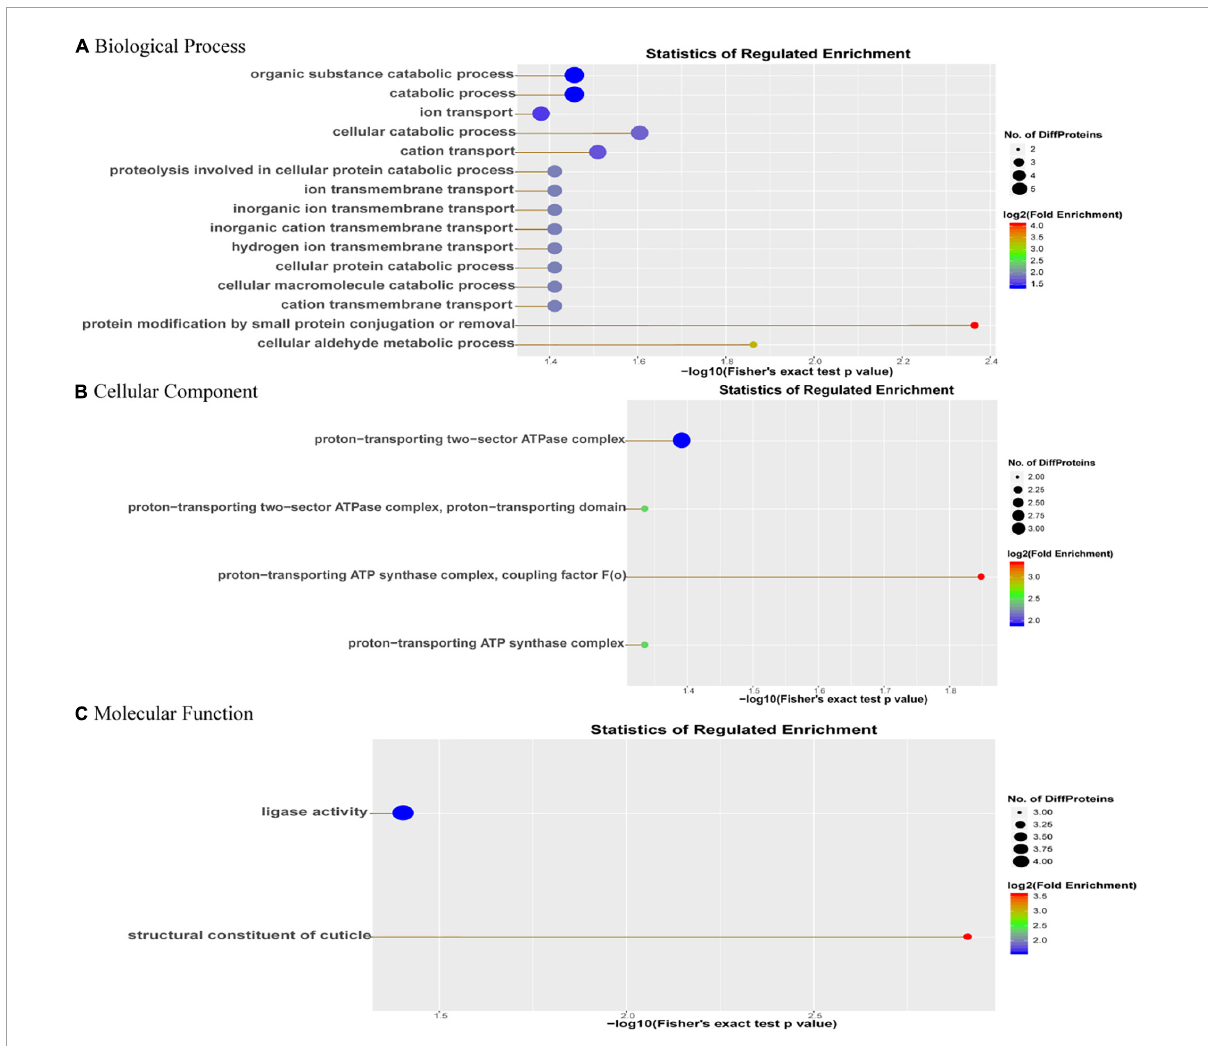
FIGURE3 GO enrichment analysis of DEPs. The abscissa is the (A) GO-biological process enrichment; (B) GO-cellular component enrichment; and (C) GO-molecular function enrichment. The abscissa is the p -value of log10 conversion. The larger the value, the higher the significance of the enrichment in this category. The ordinate represents the name of the enrichment category, and the larger the circle, the more the number of differential proteins in this category. The color of the circle represents the fold enrichment of the protein, and the redder the color, the greater the